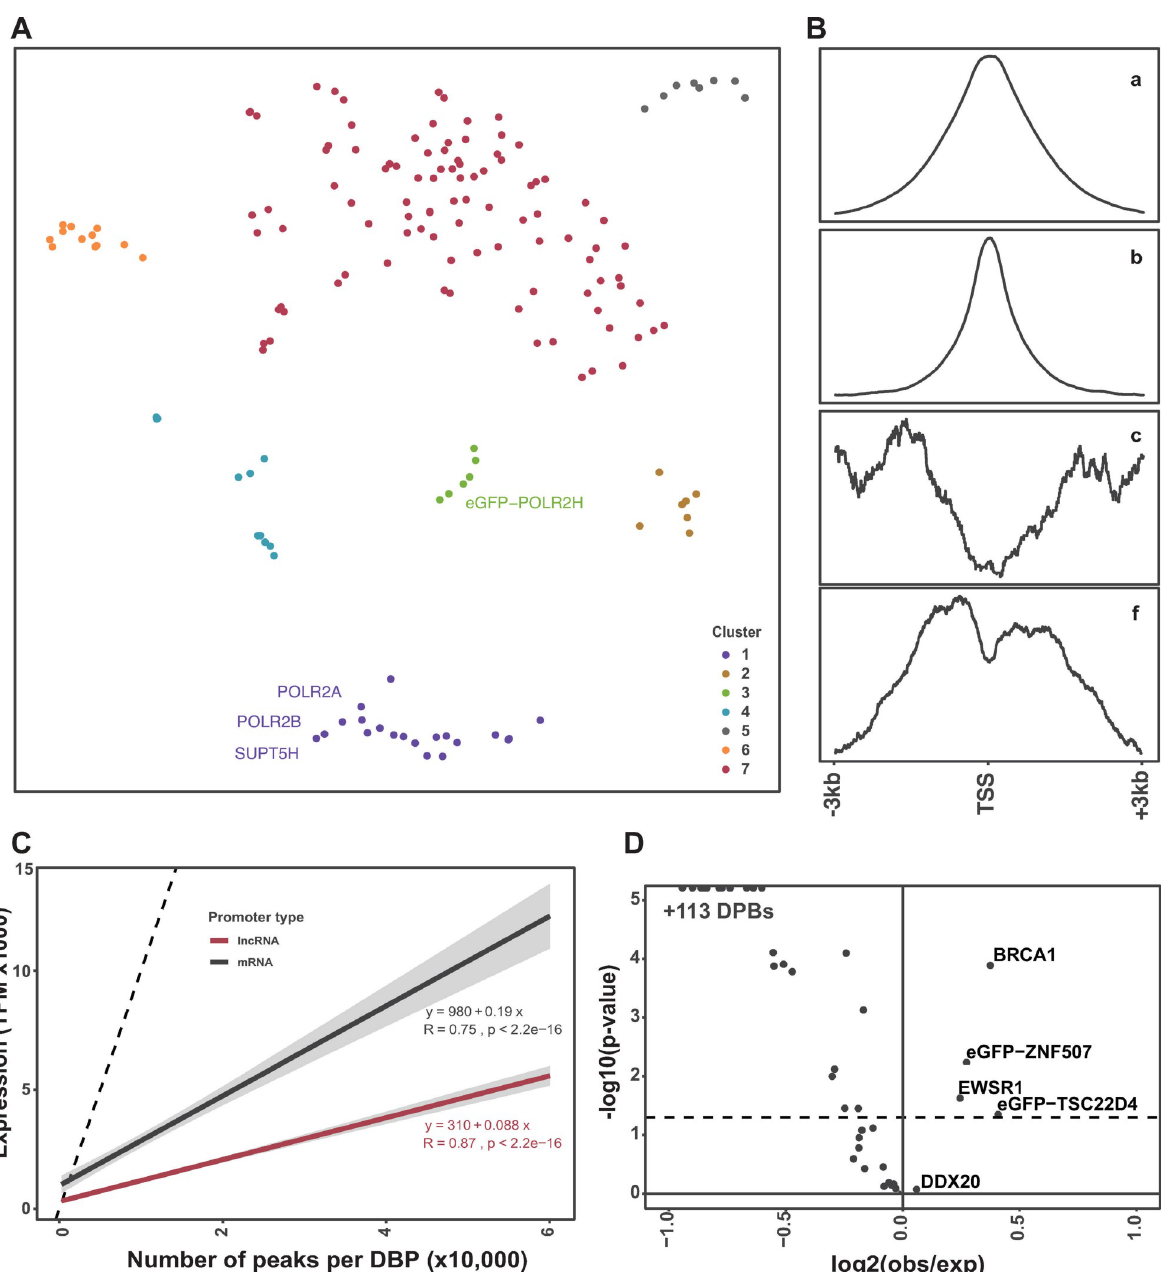
Fig 3. Binding properties of DBPs and expression output of promoters. (A) UMAP dimensionality reduction to identify DBPs with similar promoter binding profiles. (B) Four distinct clusters of binding patterns around promoter TSSs with 3Kb up and downstream. Line is the average profile of all peaks in each cluster. (C) The number of peaks per DBP versus number of mRNA or lncRNA promoter overlaps. X-axis is the number of DBPs overlapping either lncRNA (red) or mRNA (black) promoters. (D) Chi-squared test for enrichment of DBPs between lncRNAs and mRNAs. The x-axis is the log2(observed over expected) and y-axis is the -log10(p-value).